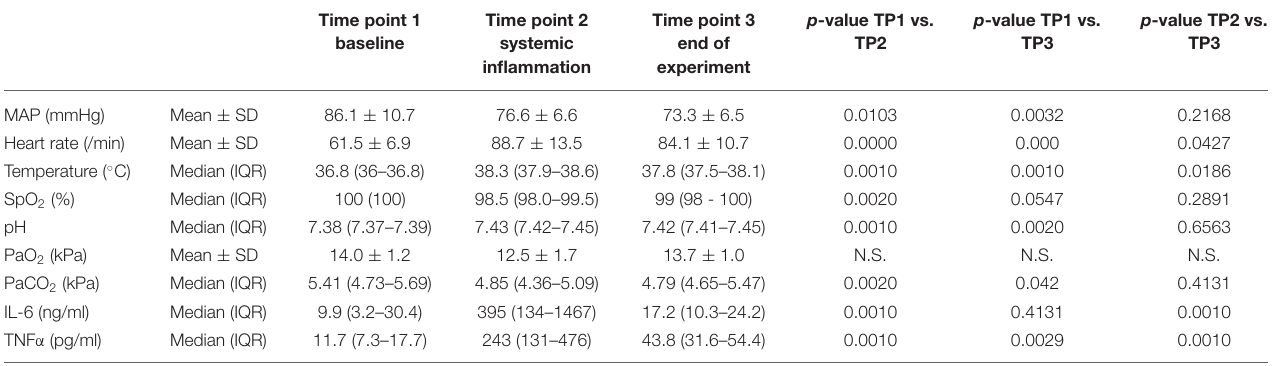
TABLE 1 | Hemodynamic and clinical parameters of the participants ( n = 11) for each time